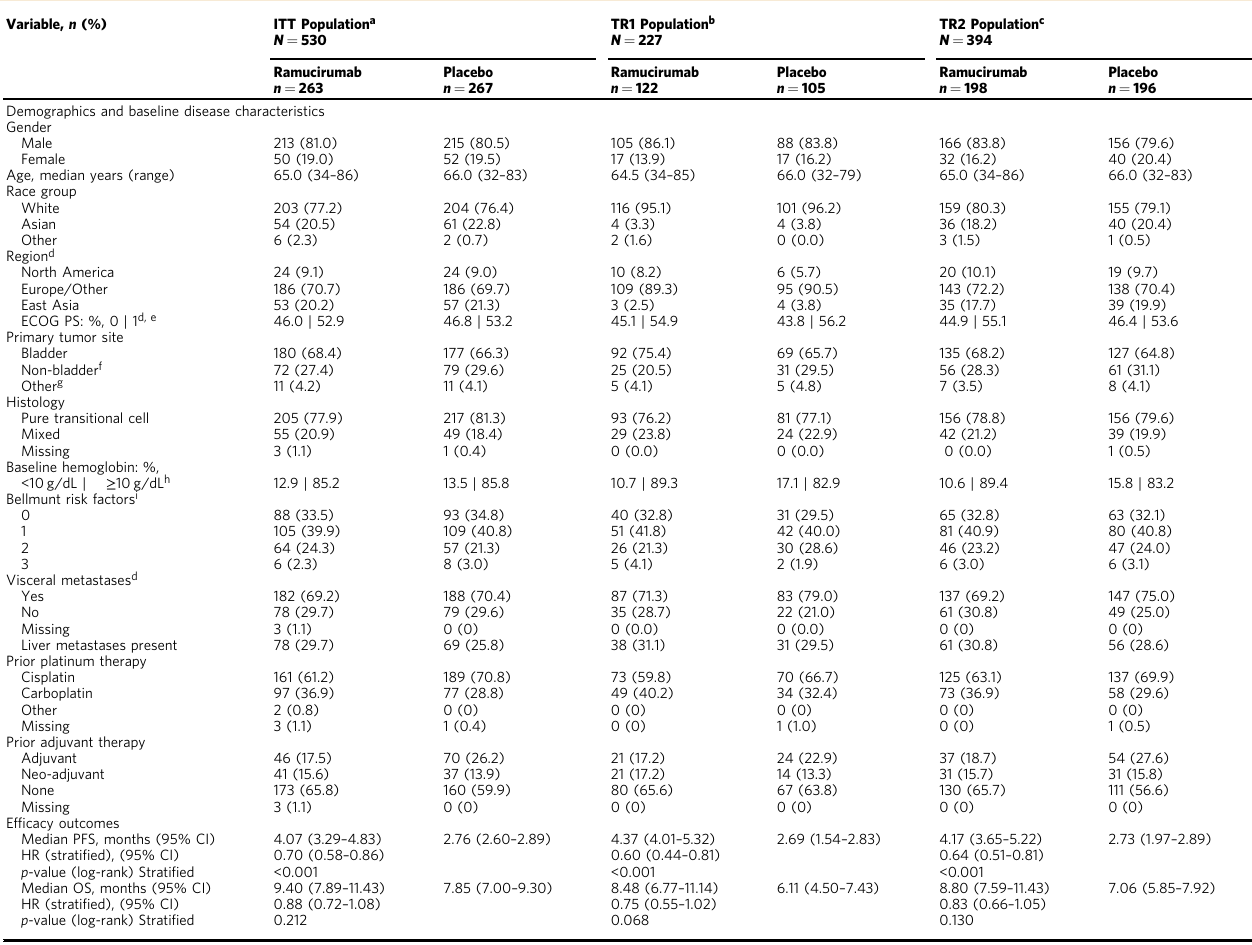
Table 1 Demographics, baseline disease characteristics, and ef fi cacy outcomes in the overall study ITT population compared to TR1 and TR2.